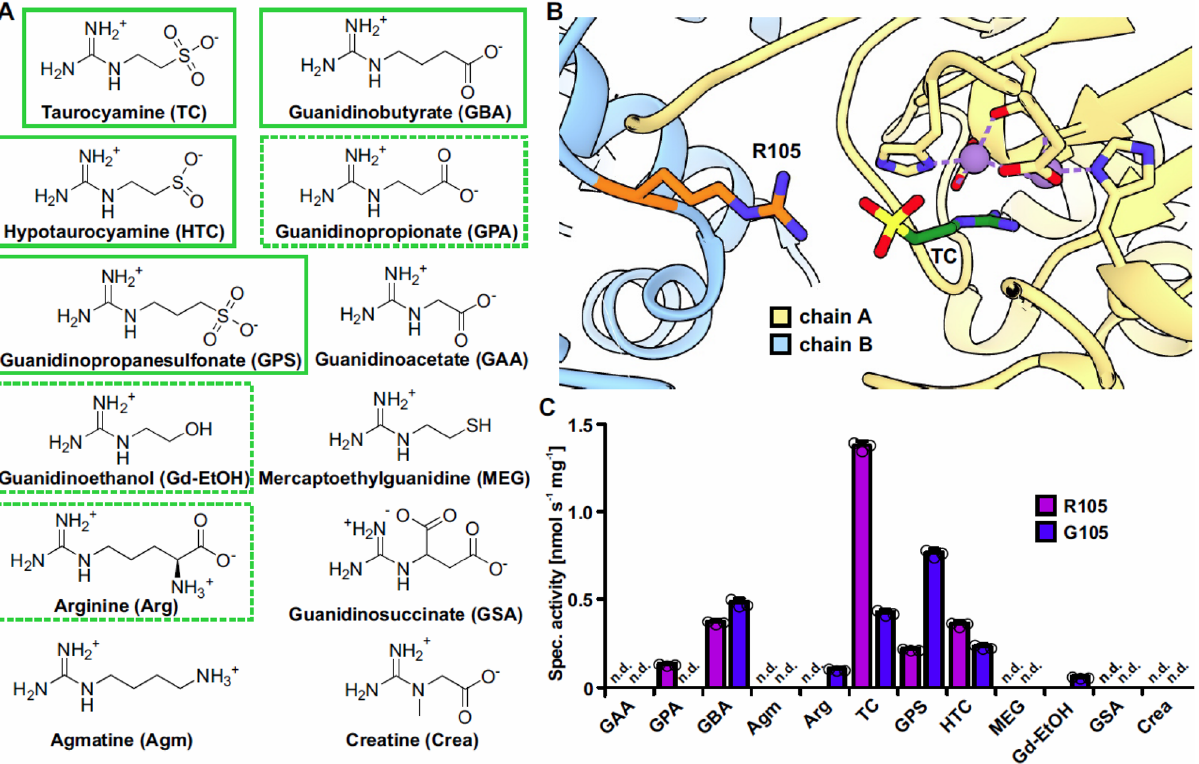
Figure 2. Structural model and substrate specificity of GDAH/AGMAT. ( A ) Structures of guanidine derivatives tested as substrates for GDAH. Boxed substrates were hydrolyzed by both variants of GDAH, whereas substrates in a dashed box were only hydrolyzed by either the R105 or the G105 variant. ( B ) Close-up of the substrate binding pocket of a GDAH model showing the position of R105 from the neighboring subunit in relation to the substrate taurocyamine (TC). A global view of the two subunits is provided in Supplementary Fig. S2. Details about the modelling and substrate docking are provided in the main text. ( C ) Specific activities of the two GDAH variants recombinantly expressed in E. coli with various substrates. Columns represent the average of technical triplicates and consistent results were obtained with independent preparations. (n.d. = not detected; limit of detection ~ 0.02 nmol s −1 mg −1 ), error bars, s.d. For the sensitivity of the colorimetric assay, see the urea calibration curve (Supplementary Fig.